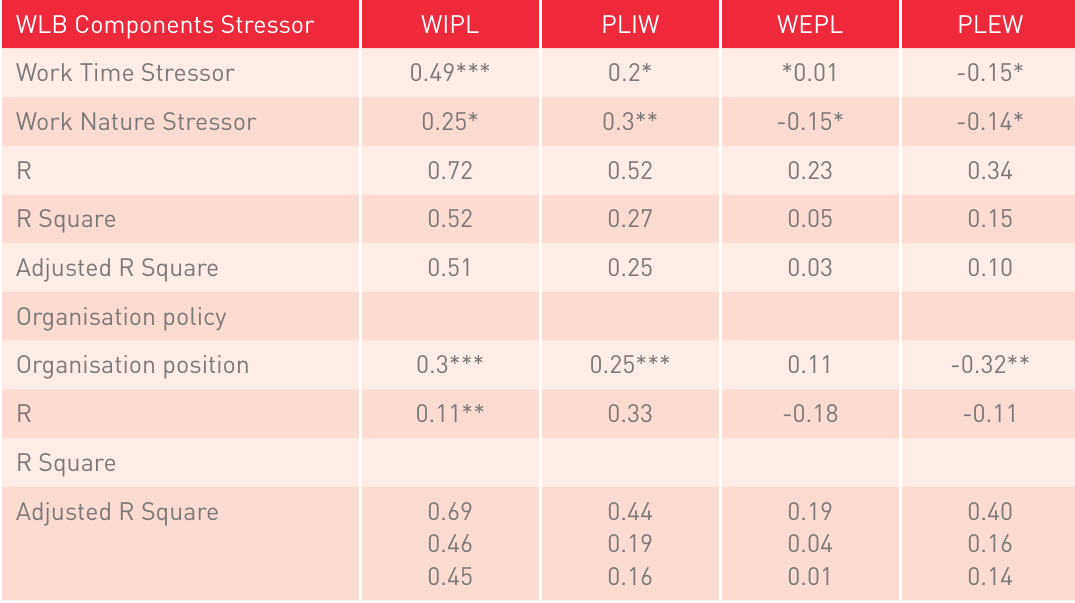
Relationship between work-related and organisation-related stressors with work-life balance